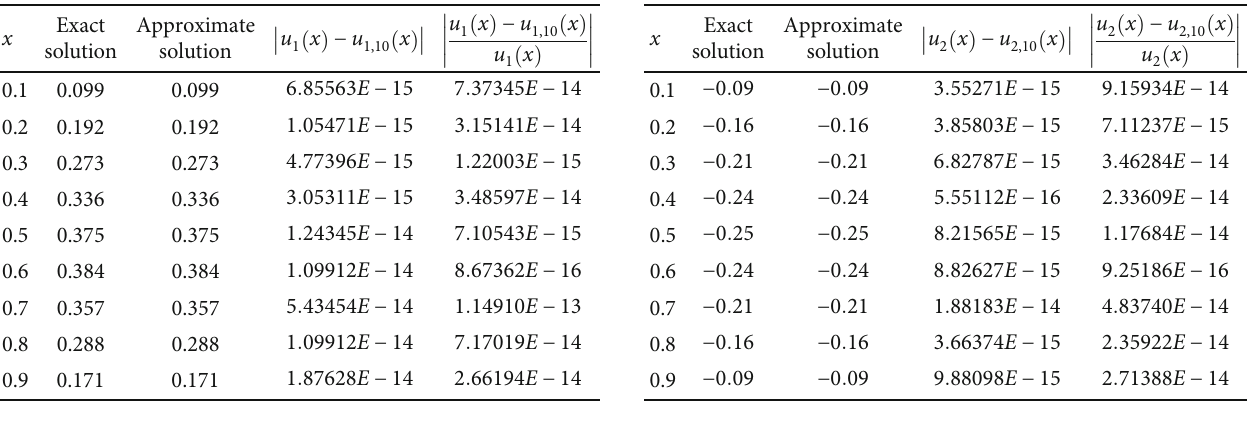
Table 1: The numerical solutions of u